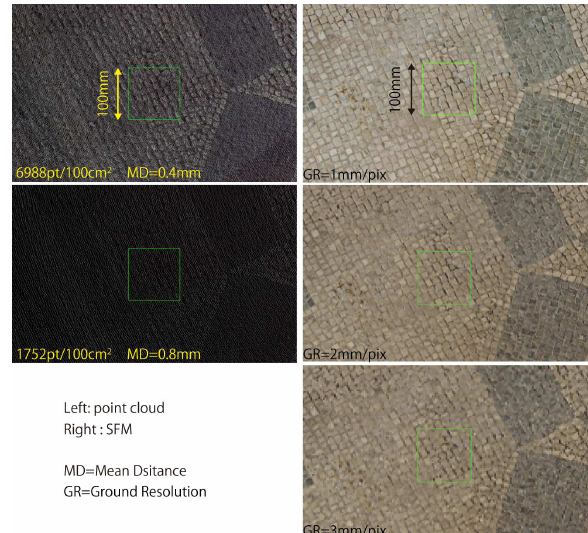
Fig.12 the comparison images of the difference of density or ground resolution